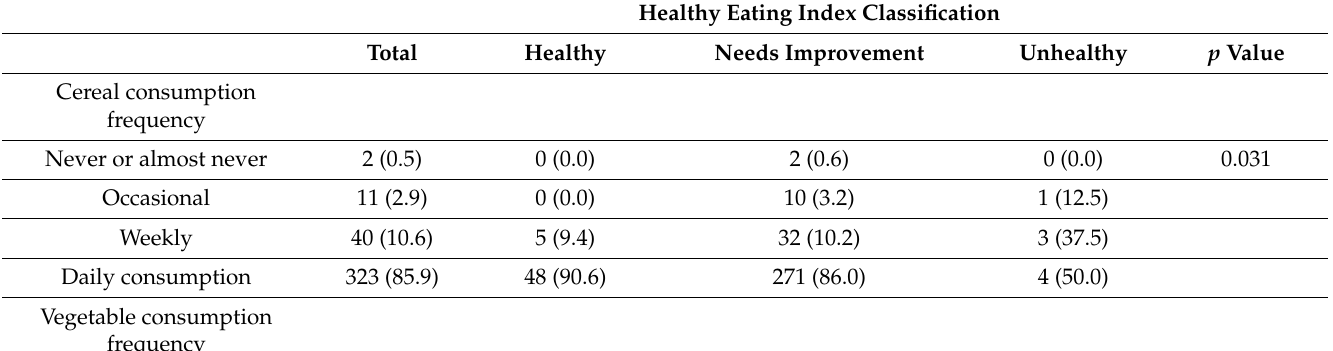
Table 3. Comparisons of food frequencies between the healthy eating index categories. Healthy Eating Index